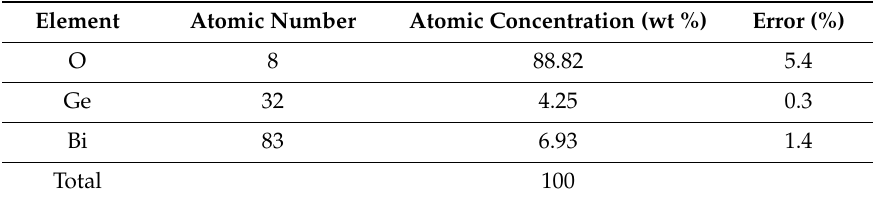
Figure 4. Elemental analysis of the sample prepared by the bismuth acetate precursor. Table 2. Atomic concentrations of the main elements in the sample prepared by the bismuth acetate precursor.